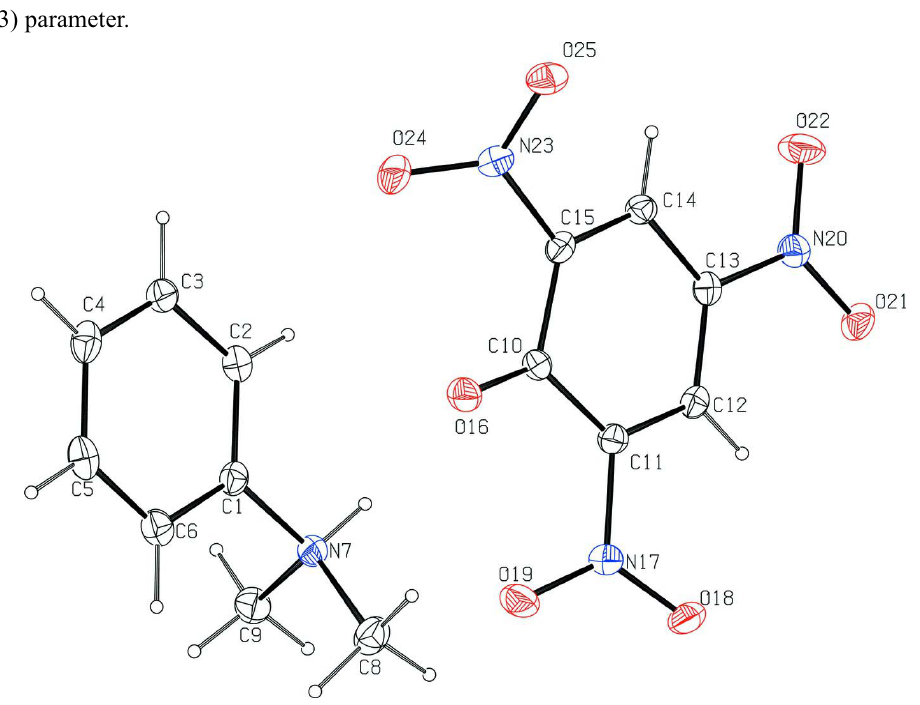
The asymmetric unit of (I) with the atoms labelled and displacement ellipsoids depicted at the 50% probability level for all non-H atoms. H-atoms are drawn as spheres of arbitrary